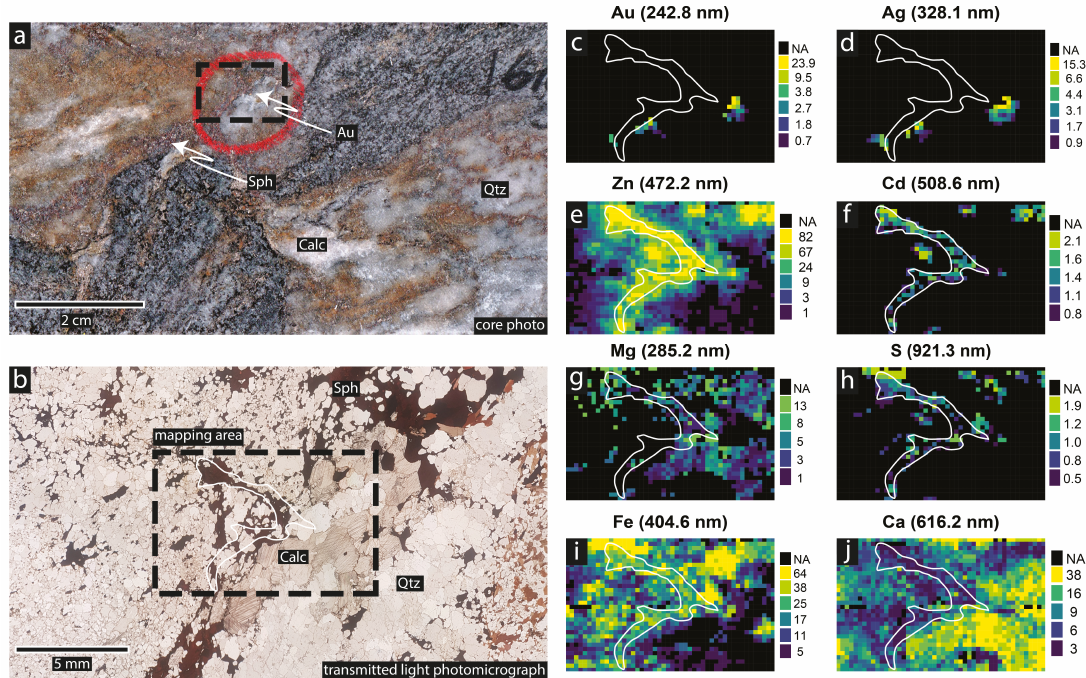
Figure 25. ( a ) Gold- and base metal-rich quartz vein from the MacLellan deposit, Lynn Lake, Manitoba. Mapping area comprises quartz (Qtz), calcite (Calc), arsenopyrite (Asp), pyrrhotite (Po), and sphalerite (Sph); ( b ) transmitted light photomicrograph of LIBS mapping area; ( c – j ) LIBS results for Au ( c ), Ag ( d ), Zn ( e ), Cd ( f ), Mg ( g ), S ( h ), Fe ( i ), and Ca ( j ) were processed using new R code and are displayed as relative wavelength intensities (%). Each mineral phase identified within the mapping area can identified based on its LIBS spectral signature and some prior knowledge of the main mineral-forming elements. Minor to trace elements associated with each mineral can be used to support mineral identification ( g ). Geochemical imaging is also e ff ective at mapping the distribution of minute minerals of significant economic interest, including native Au inclusions ( d , e ). Maps were acquired in an Ar environment on the unprepared surface of the cut drill